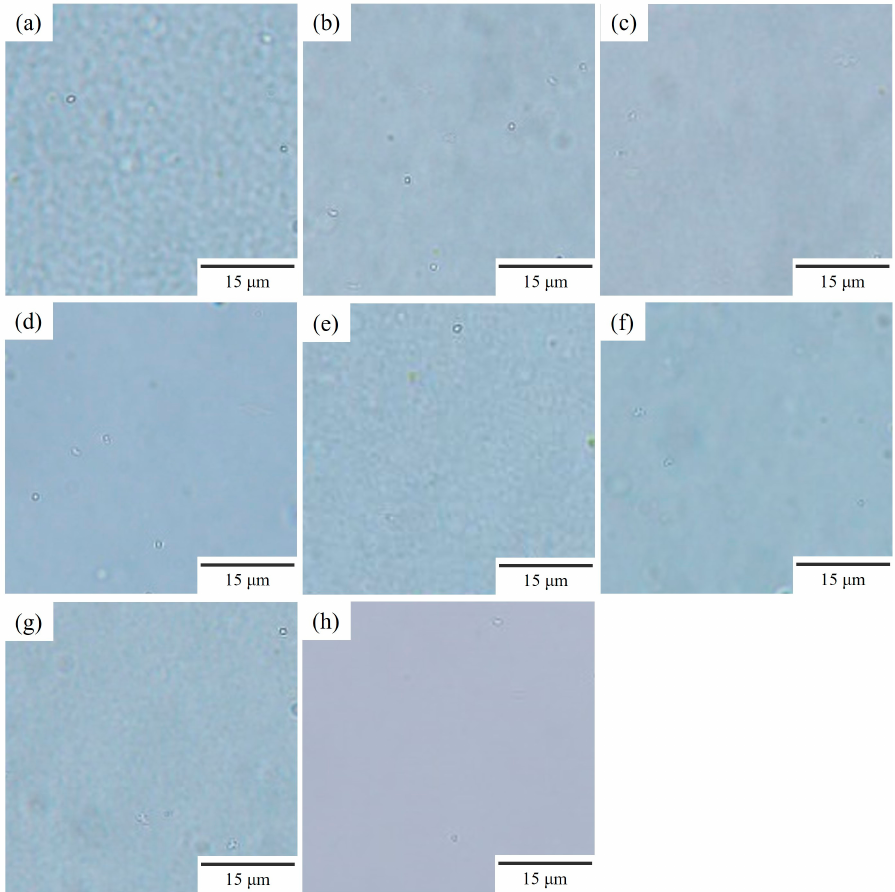
Figure 1. Optical micrographs for phase structure of NBR/PVC blends at various compositions ob- tained by annealing the solvent-cast films at various temperatures for 1 h: ( a ) 95/5 NBR/PVC, 150 ◦ C; ( b ) 80/20 NBR/PVC, 150 ◦ C; ( c ) 60/40 NBR/PVC, 150 ◦ C; ( d ) 20/80 NBR/PVC, 150 ◦ C; ( e ) 95/5 NBR/PVC, 130 ◦ C; ( f ) 80/20 NBR/PVC, 130 ◦ C; ( g ) 60/40 NBR/PVC, 130 ◦ C; ( h ) 20/80 NBR/PVC, 130 ◦